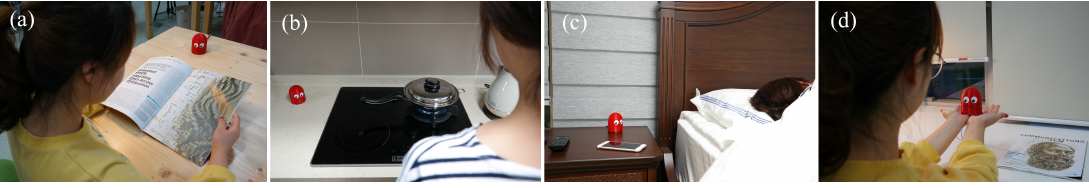
Figure 11. Applications of the proposed knocking and sensing strategy in various interaction scenarios: AI speaker interacting with a user on the desk ( a ), on the kitchen table ( b ), in the bed room ( c ), and on the palm of the hand ( d